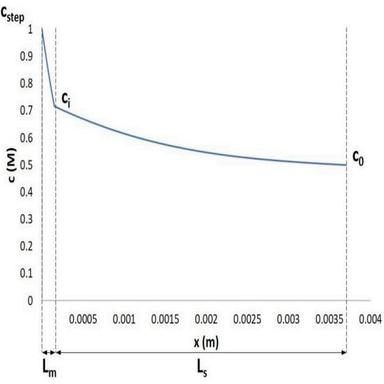
Non-stationary salt-concentration profile in the system studied in this work.